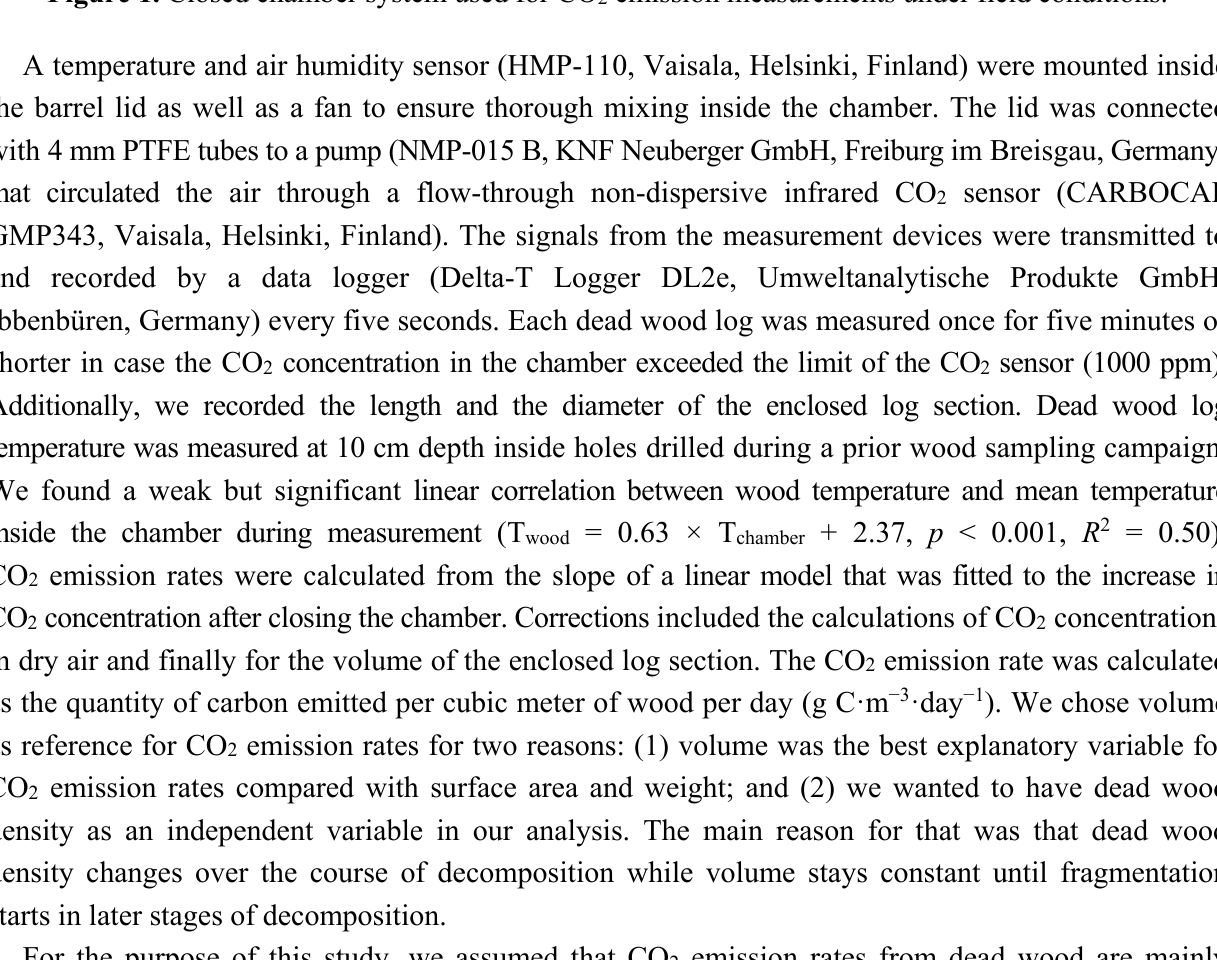
Figure 1. Closed chamber system used for CO 2 emission measurements under field